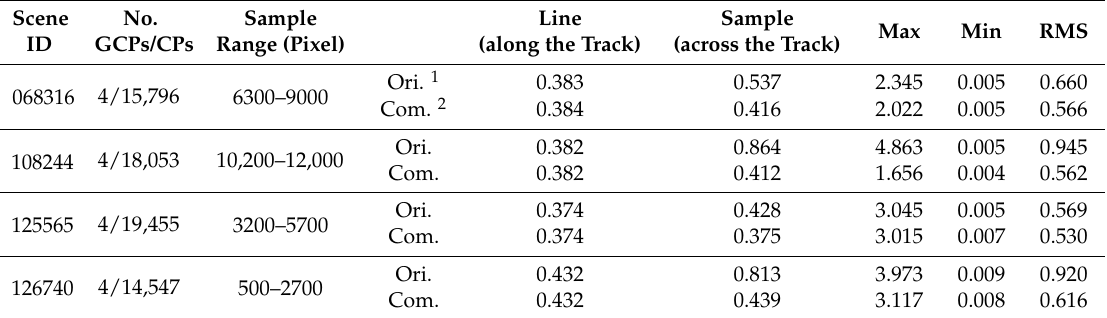
Table 4. Orientation accuracy before and after compensation for distortion (unit: pixel).